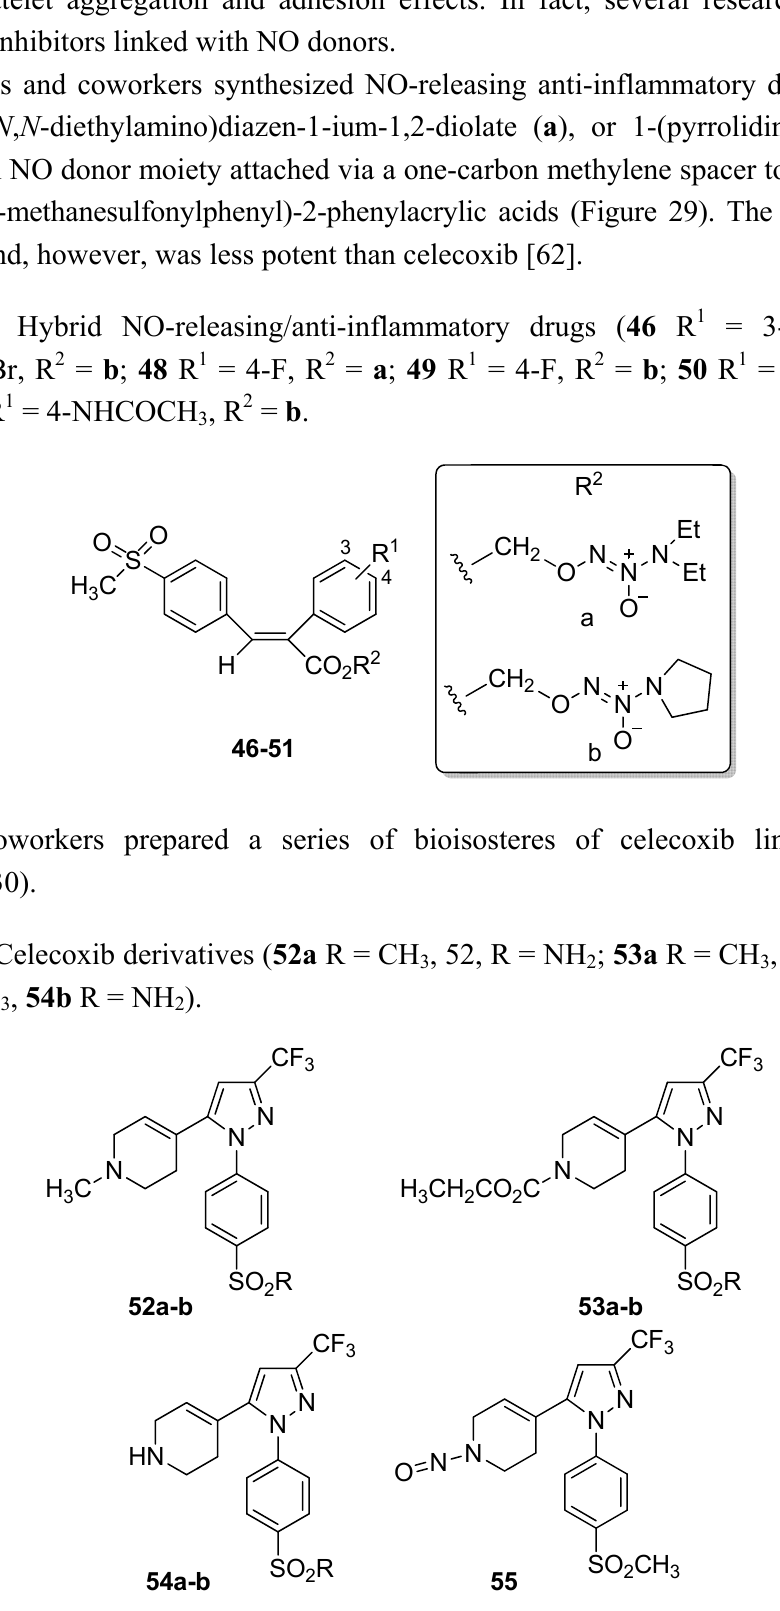
Figure 29. Hybrid NO-releasing/anti-inflammatory drugs ( 46 R 1 = 3-Br, R 2 = a ;